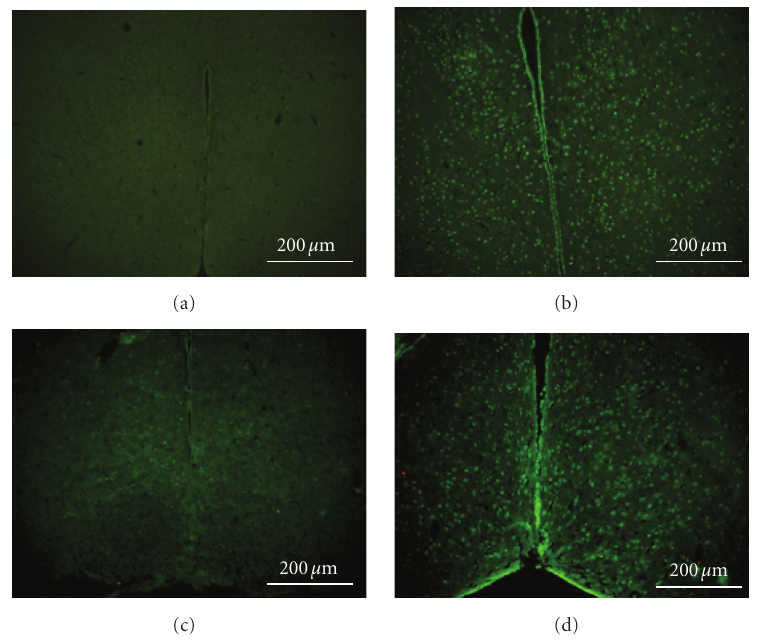
Figure 3: Photomicrographs of TUNEL, staining of the hypothalamus for a normothermic control (NC) (a), a sham-operated, heatstroke (SOH) mouse (b), a castrated, vehicle-treated heatstroke (CVH) mouse (c), and a castrated, testosterone-treated (CTH) mouse (d).